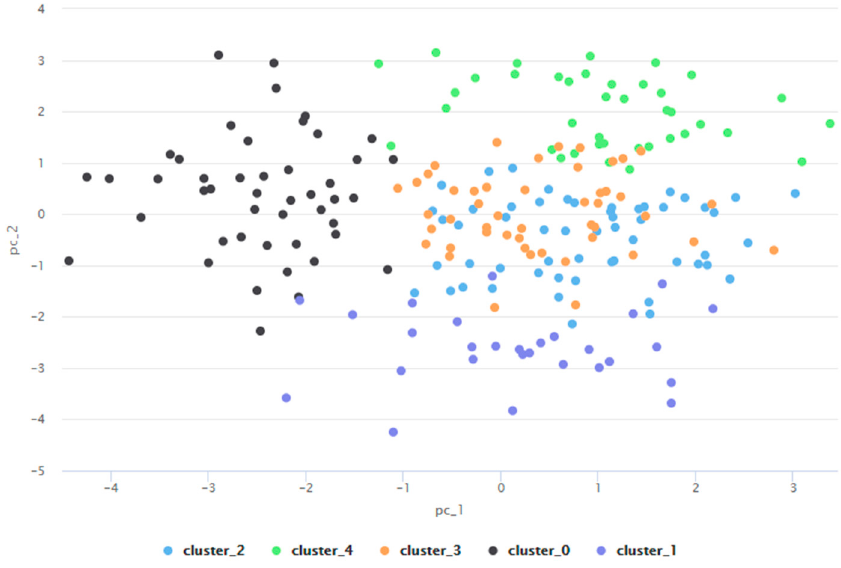
Figure A1. Distribution of the dataset into its two principal components separated in color by clusters.